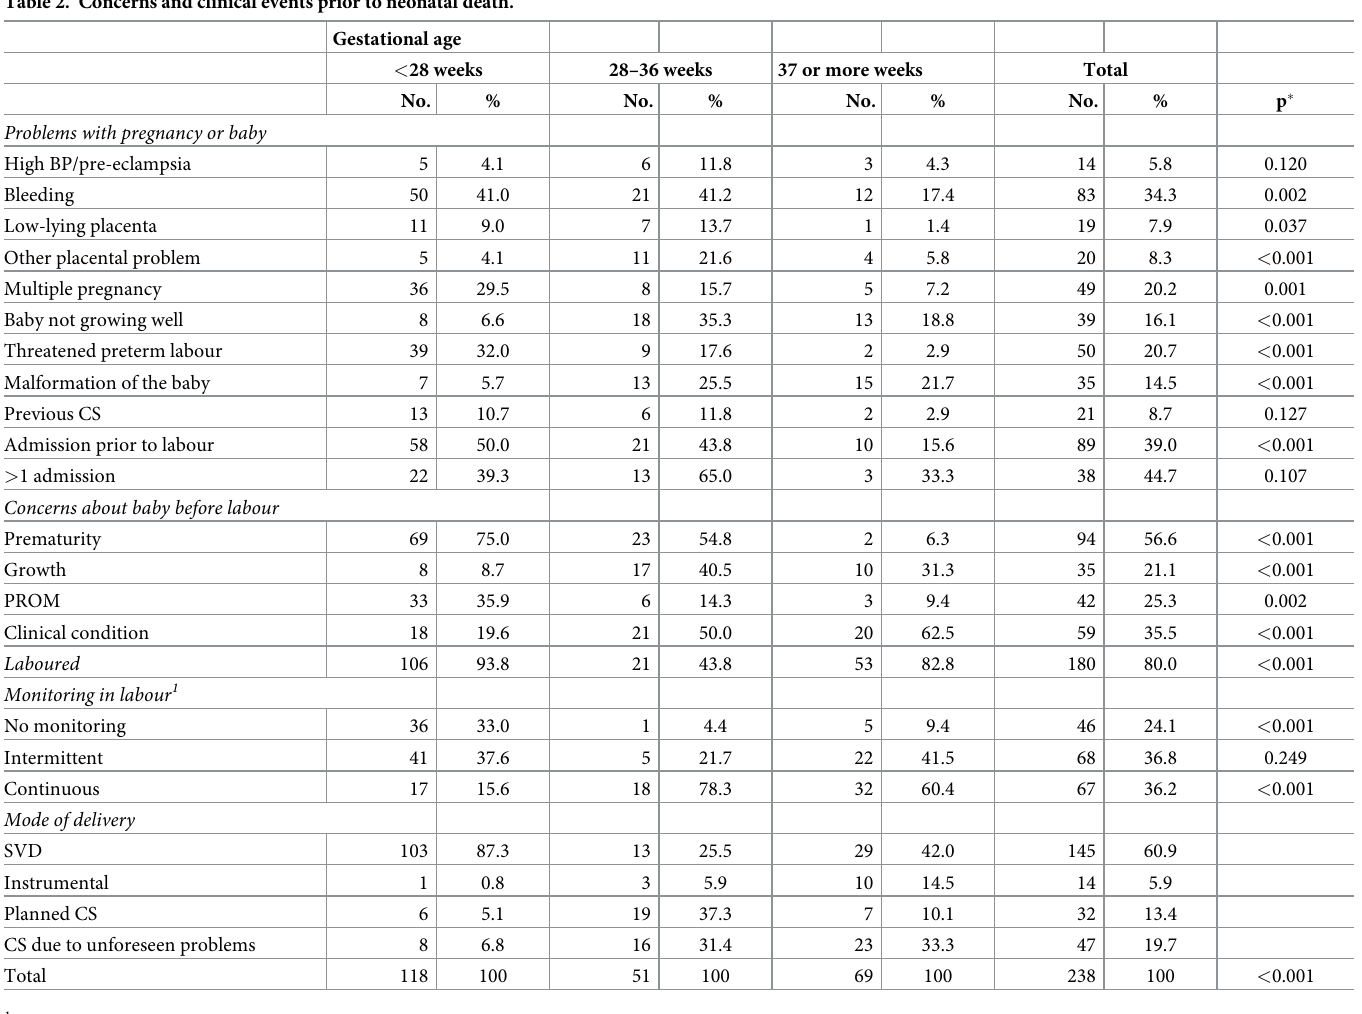
Table 2. Concerns and clinical events prior to neonatal